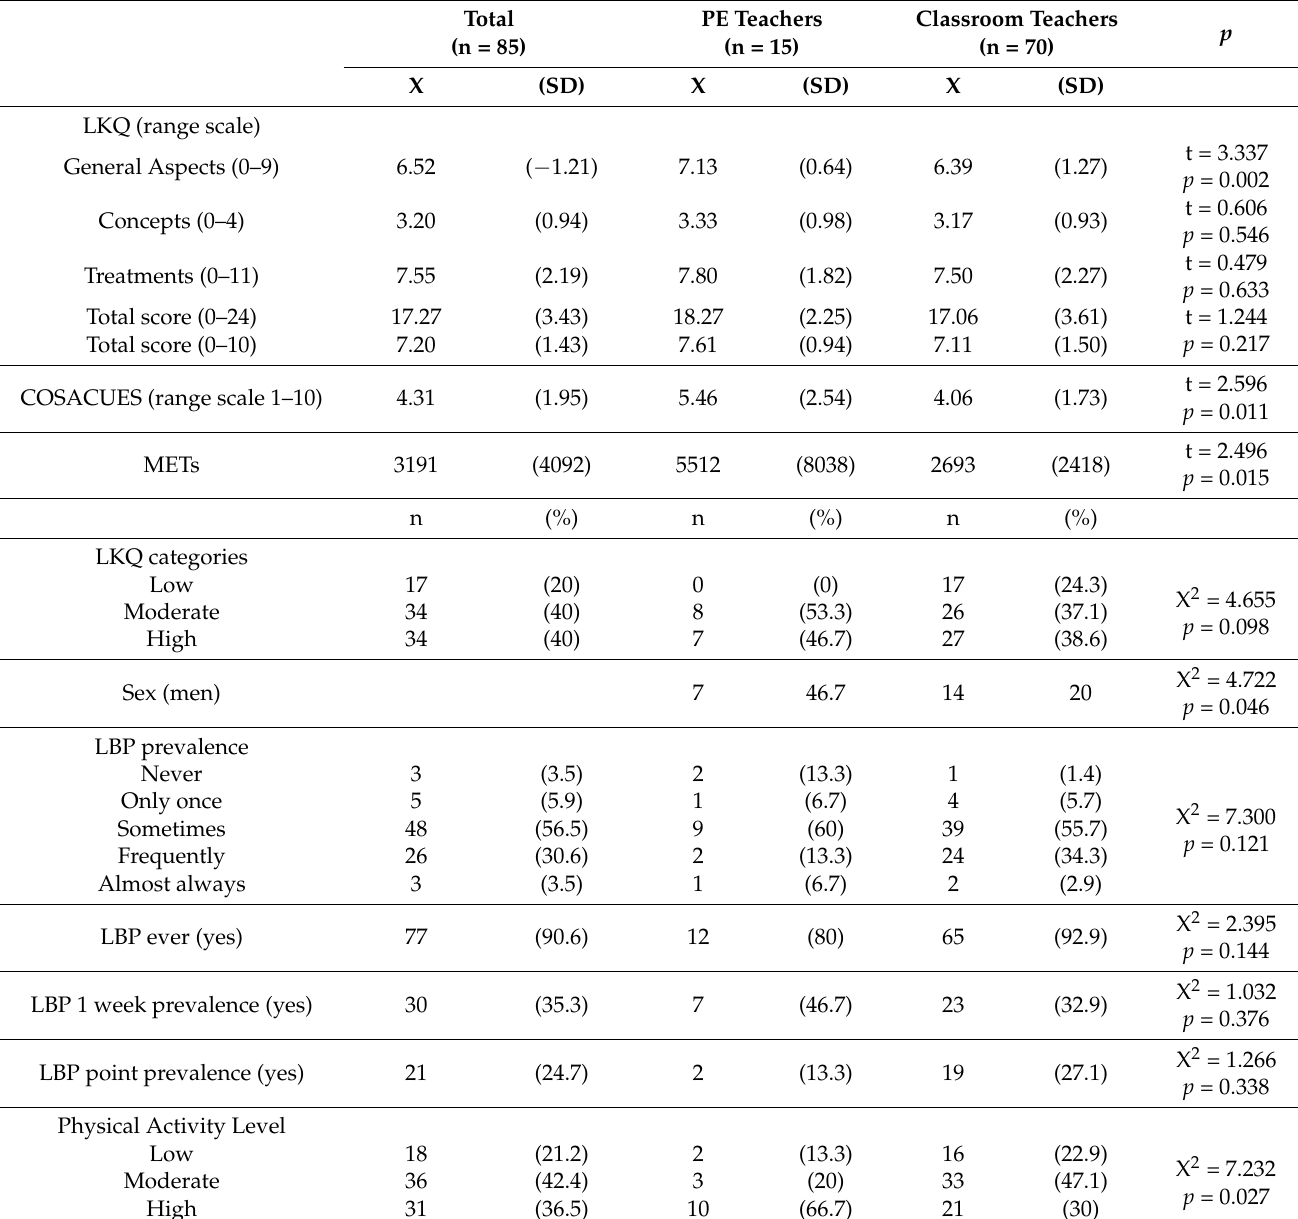
Table 2. Characteristics of the sample by kind of